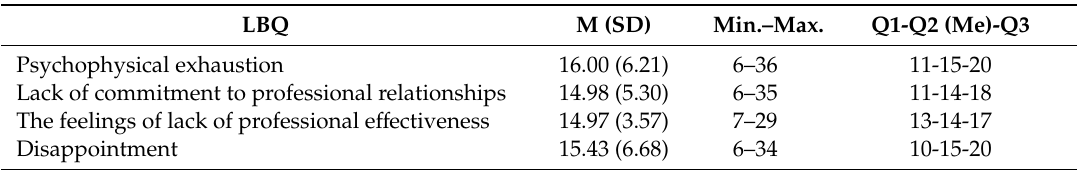
Table 5. The level of occupational burnout in nurses, as assessed by the Occupational Burnout Questionnaire (LBQ).